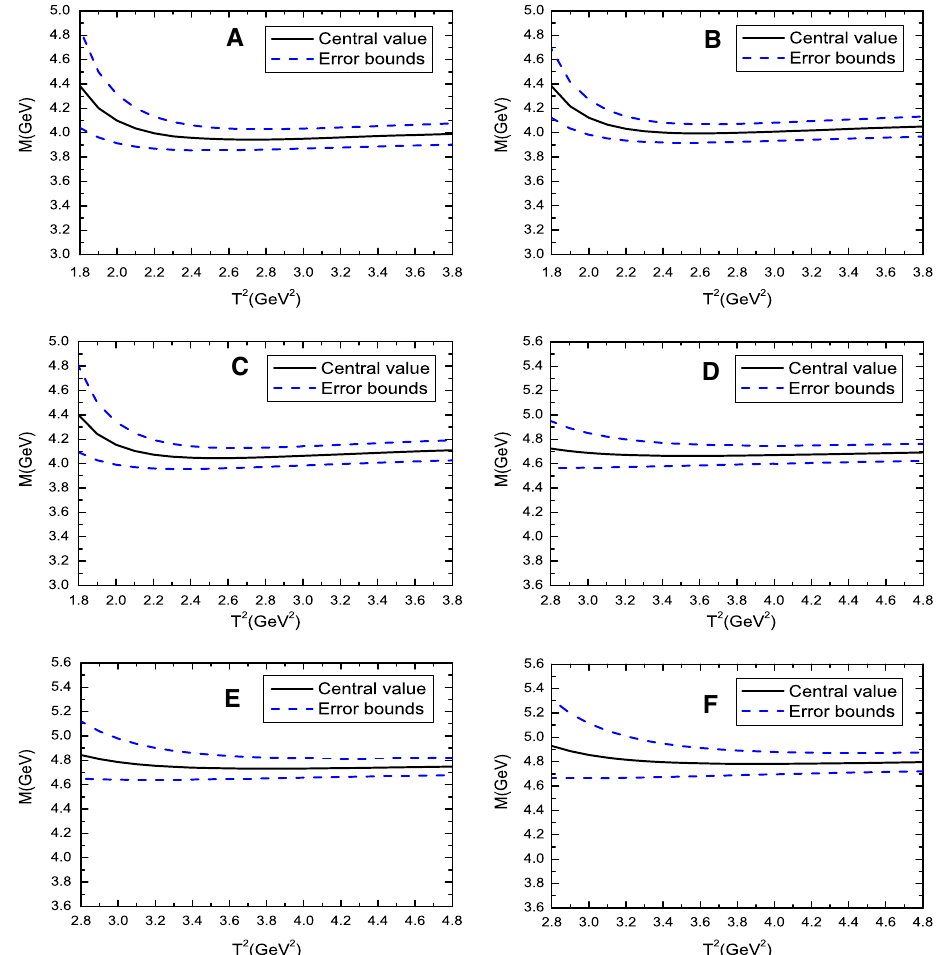
Fig. 3 The masses with variations of the Borel parameters, where a – f denote the tetraquark states cc ¯ u ¯ d ( 2 + ) , cc ¯ u ¯ s ( 2 + ) , cc ¯ s ¯ s ( 2 + ) , cc ¯ u ¯ d ( 1 − ) , cc ¯ u ¯ s ( 1 − ) and cc ¯ s ¯ s ( 1 − ) ,